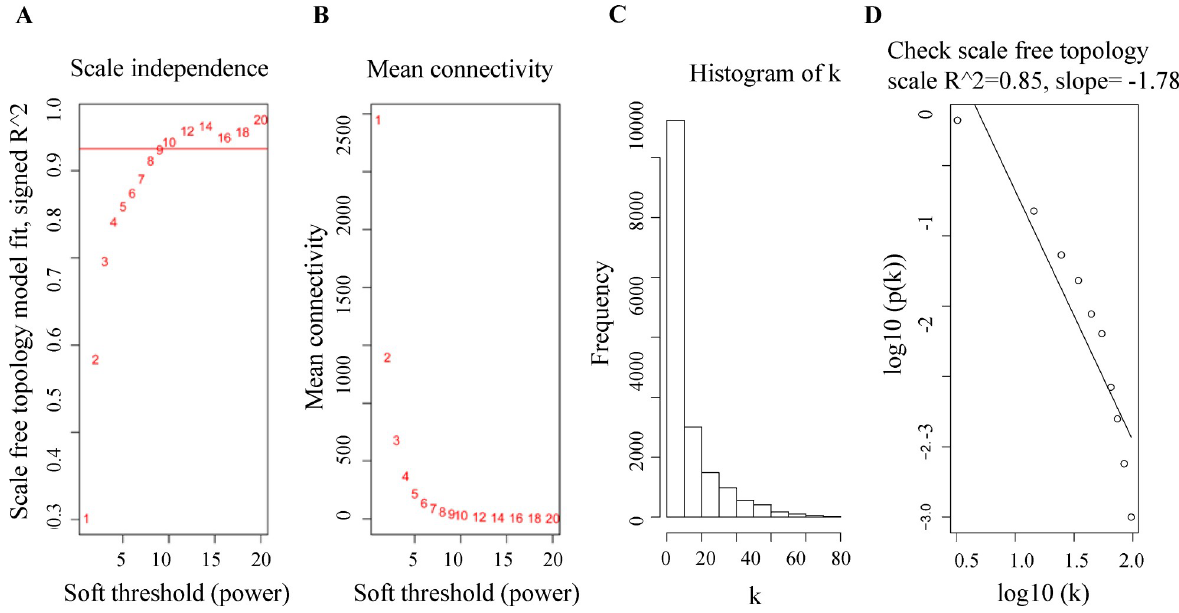
Fig 2. Construction of the weighted gene co-expression network of gene modules. (A) Analysis of the scale independence for the appropriate soft-thresholding power β . (B) Analysis of the mean connectivity for the appropriate soft-thresholding power β . (C) Histogram of connectivity distribution with an appropriate β = 9. (D) Checking the scale-free topology with an appropriate β = 9.